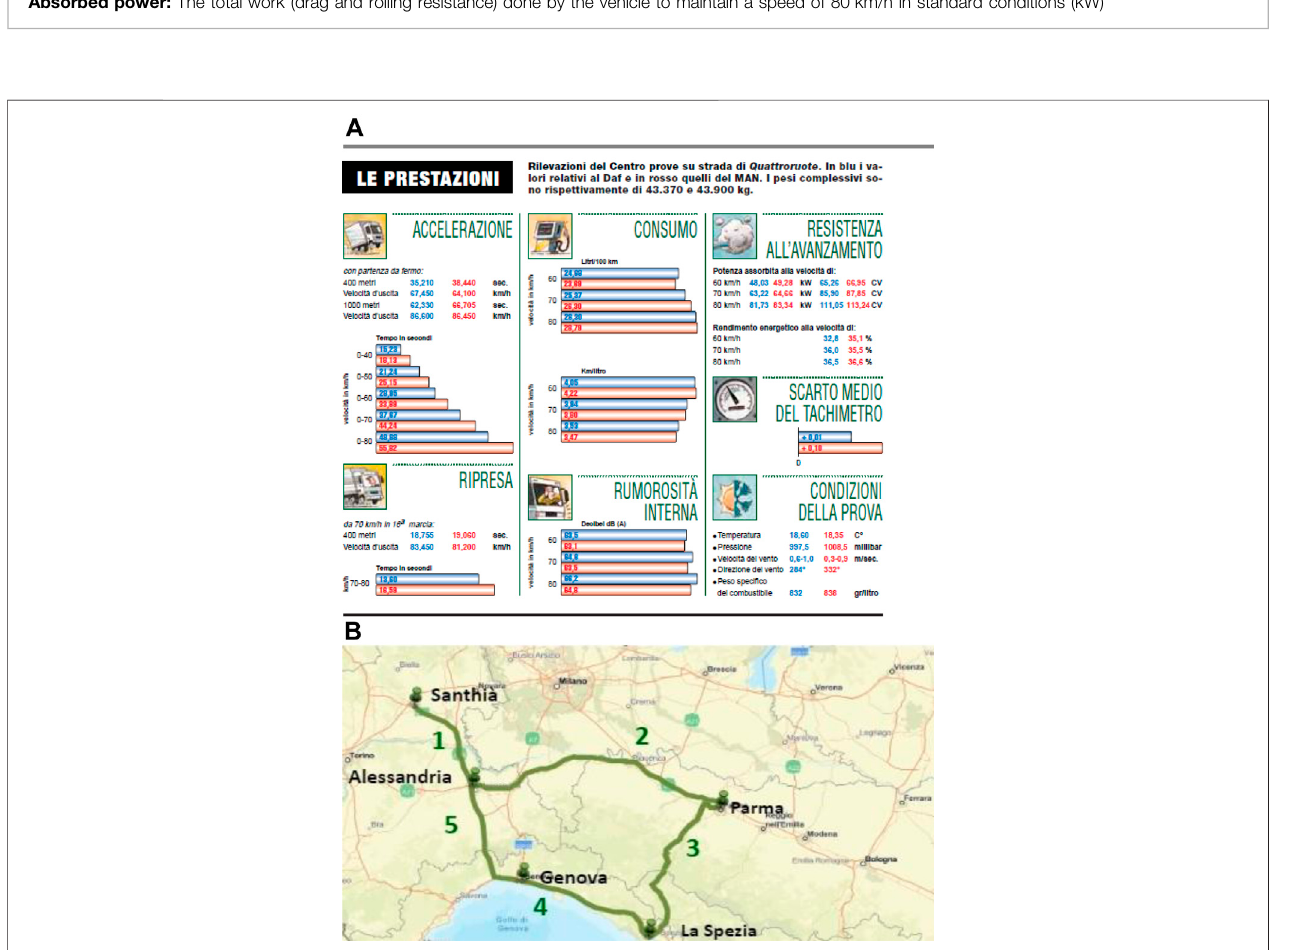
FIGURE1| Performanceandon-roadtest. Thedatareferstotwodifferenttests, generallyperformedontwosuccessivedayswiththesame vehicleandsetting: 1) performancetest(short-track)performedalwaysonthesame fl atandstraightstretchofroad,withmonitoredenvironmentalconditions(temperature,humidityandwind) and data gathered with speci fi c instruments (UNI-EN Iso 9001:2008) at different speeds/accelerations ( (A) , source: (TuttoTrasporti), 210, September 1999). Absorbed power is assessed by launching the fully loaded truck at the speed of 85 km/h and measuring the work done from 80 km/h until it stops by inertia. 2) on-road test (long-track) performed on four highway-routes, with mixed road conditions ofslope and speed.The example (B) shows theroute Santhià-Alessandria-La Spezia, witha total of 544.2 km. The fuel consumption measurement is carried out with an on-board fl ow meter. This tool can be installed on the power circuit or, as happens more often, it is the on-board computer that measures the time and openings of the injectors and calculates the quantity of diesel per cylinder every cycle. A second measurement of the fuel consumed is conducted at the end of the test, when the truck tank is refuelled at the same gas station and position used before the departure (theprecisepositionisrecordedbytrackingspeci fi csignsontheroad).Theassessmentisdonewithathermometersensorbyadjustingthevolumegrowthoftheheated fuel during the test due to the injector ’ s return.